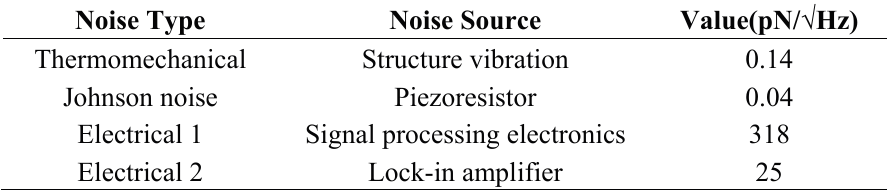
Table 2. Estimation of the values of the different noise